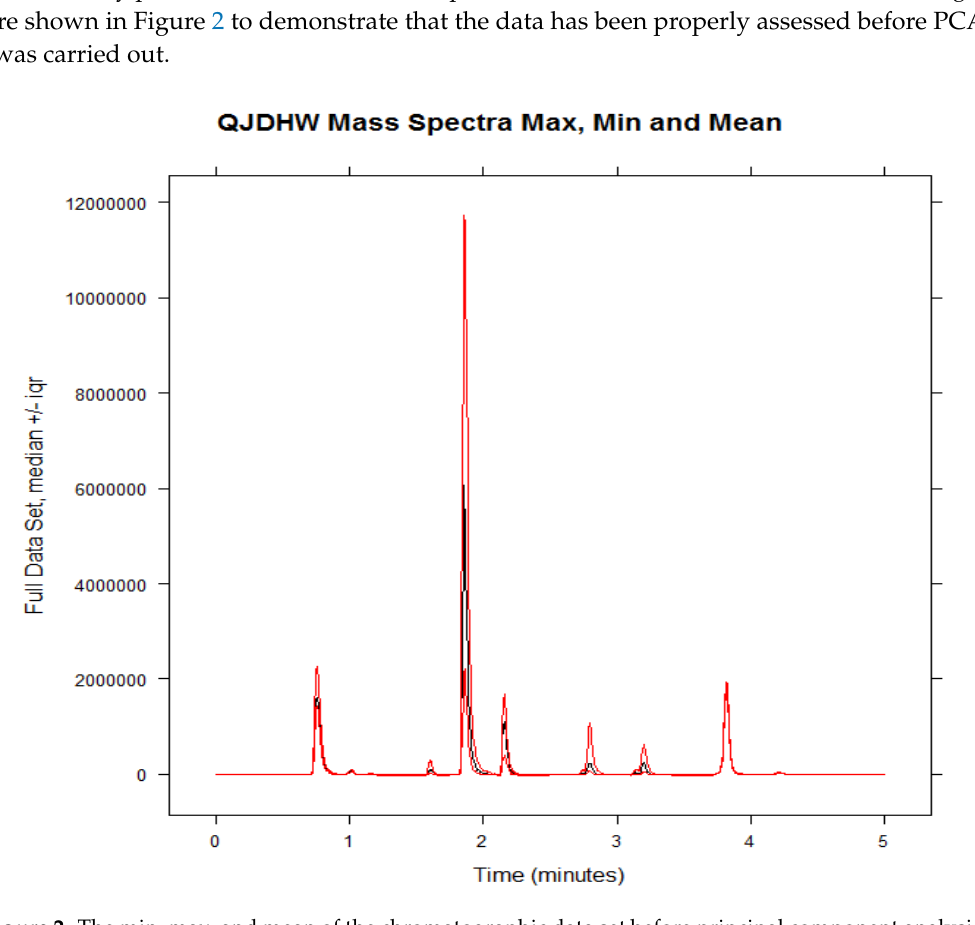
Figure 2. The min, max, and mean of the chromatographic data set before principal component analysis (PCA) was performed.